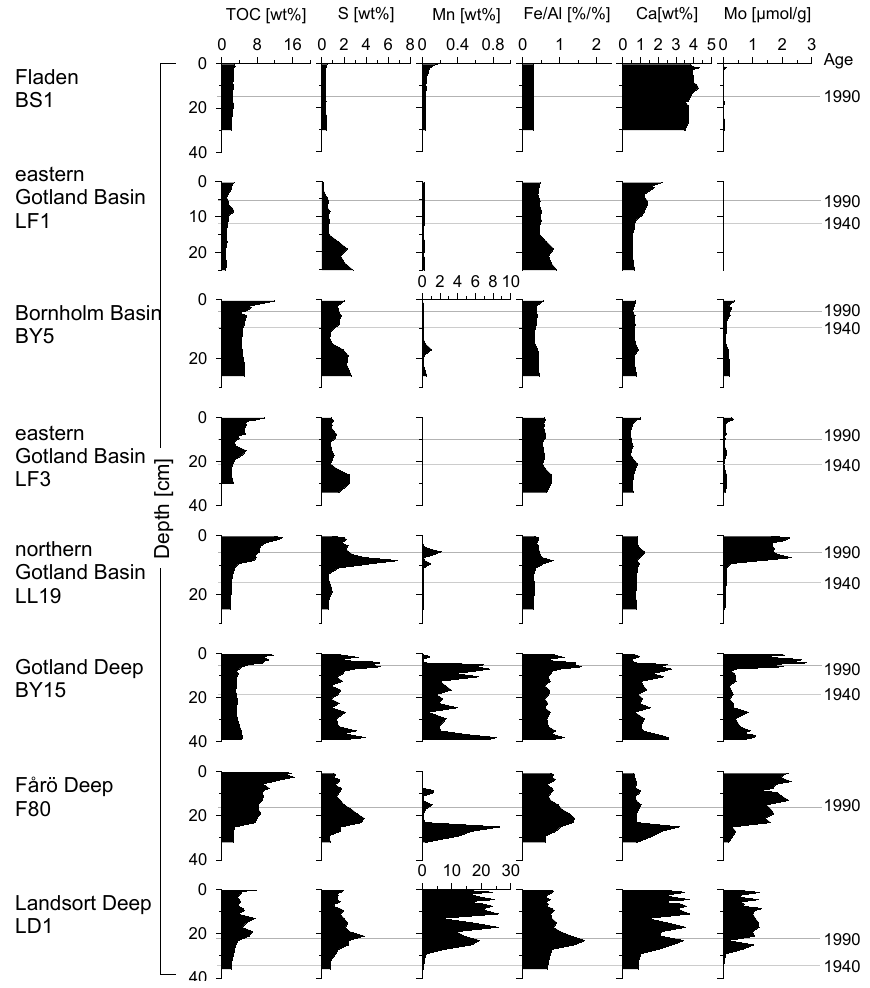
Figure 4. Sediment depth profiles of total organic carbon (TOC), sulfur (S), manganese (Mn), iron to aluminum ratio (Fe / Al), calcium (Ca) and molybdenum for all eight sites. Note the different scale for manganese at Fladen and LF1, and LD1. Grey lines indicate the years 1990 and 1940, based on sediment dating. These date markers are used to demonstrate the variability of sedimentation rates in the study